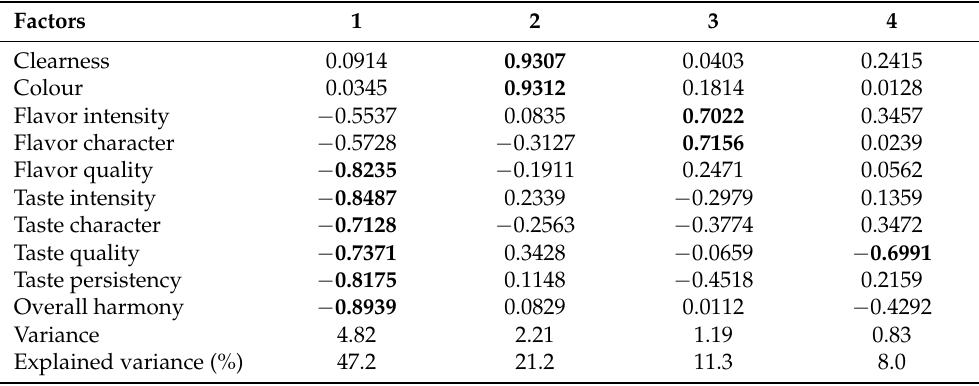
Table 15. Factor loadings for ten organoleptic parameters of white wine calculated from principal axis factor analysis (Varimax rotation). Factor loadings above 0.69 were significant at p = 0.05. Bold figures represent the significant ( p < 0.05) factor